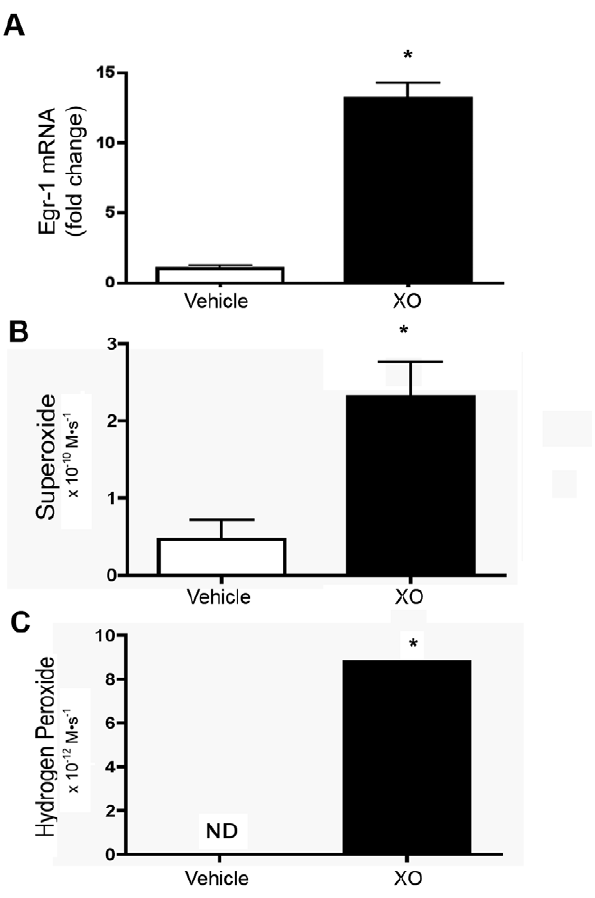
Figure 4. Xanthine oxidase upregulates Egr-1 in calf pulmo- nary artery smooth muscle cells. ( A ) Egr-1 mRNA expression was measured by qPCR in PASMC exposed to xanthine oxidase (XO- 8 mU/ mL) and hypoxanthine (0.5 mM) at 37 u C for 1 hour (XO). Data are expressed as fold change in Egr-1/HPRT relative to vehicle treated cells and presented as mean 6 SEM. *p , 0.05 vs. vehicle treated cells. B. Extracellular O 2. 2 was measured by the SOD-inhibitable reduction of XTT in XO + hypoxanthine-treated (XO), and vehicle-treated smooth muscle cells with and without SOD (500 U/mL). 20,000 cells were treated in a final volume of 150 m L and exposed to XTT for 1 hour at 37 u C and pH 7.4. An extinction coefficient of 21600 M 2 1 cm 2 1 (XTT) was used to calculate O 2. 2 flux and data expressed in M N s 2 1 . *p , 0.05 vs. vehicle-treated cells, n=3. C. H 2 O 2 was measured with a standard fluorometric assay utilizing in which H 2 O 2 reacts with HRP to forms compound I, which subsequently oxidizes p HPA to its dimer form which can be detected on a fluorometer. Experiments were performed with 30,000 cells per well and a final volume of 150 m L for 2 hours at 37 u C and pH 7.4 and H 2 O 2 flux expressed in M N s 2 1 . *p , 0.05 vs. vehicle- treated cells, n=3. Data expressed as mean 6 SEM. doi:10.1371/journal.pone.0027531.g004 detection in vehicle-treated cells, though the rate of accumulation of H 2 O 2 was lower than the production of O 2. 2 indicating that extracellular H 2 O 2 was being rapidly removed by the cells, likely through GSH ( Figure 4C ). Compared to PASMC treated with XO/HX, exposure of cells to hypoxia produced a significantly smaller rise in Egr-1 mRNA ( Figure 5A ) as well as less extracellular O 2. 2 production ( Figure 5B ). Low dose antimycin A, at a dose known to generate endogenous ROS due to inhibition of complex III of the mitochondrial electron transport chain, did not upregulate Egr-1, though high dose antimycin A did result in an increase in Egr-1 mRNA ( Figure 5C ).